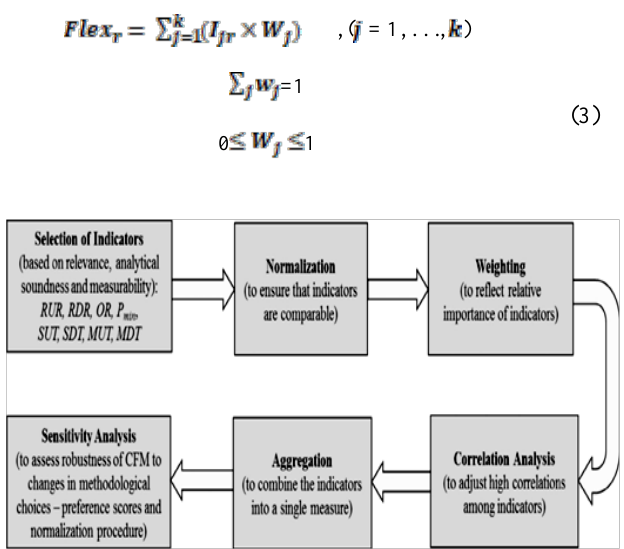
Figure 3. The sequence of steps for building up a compound flexibility metric